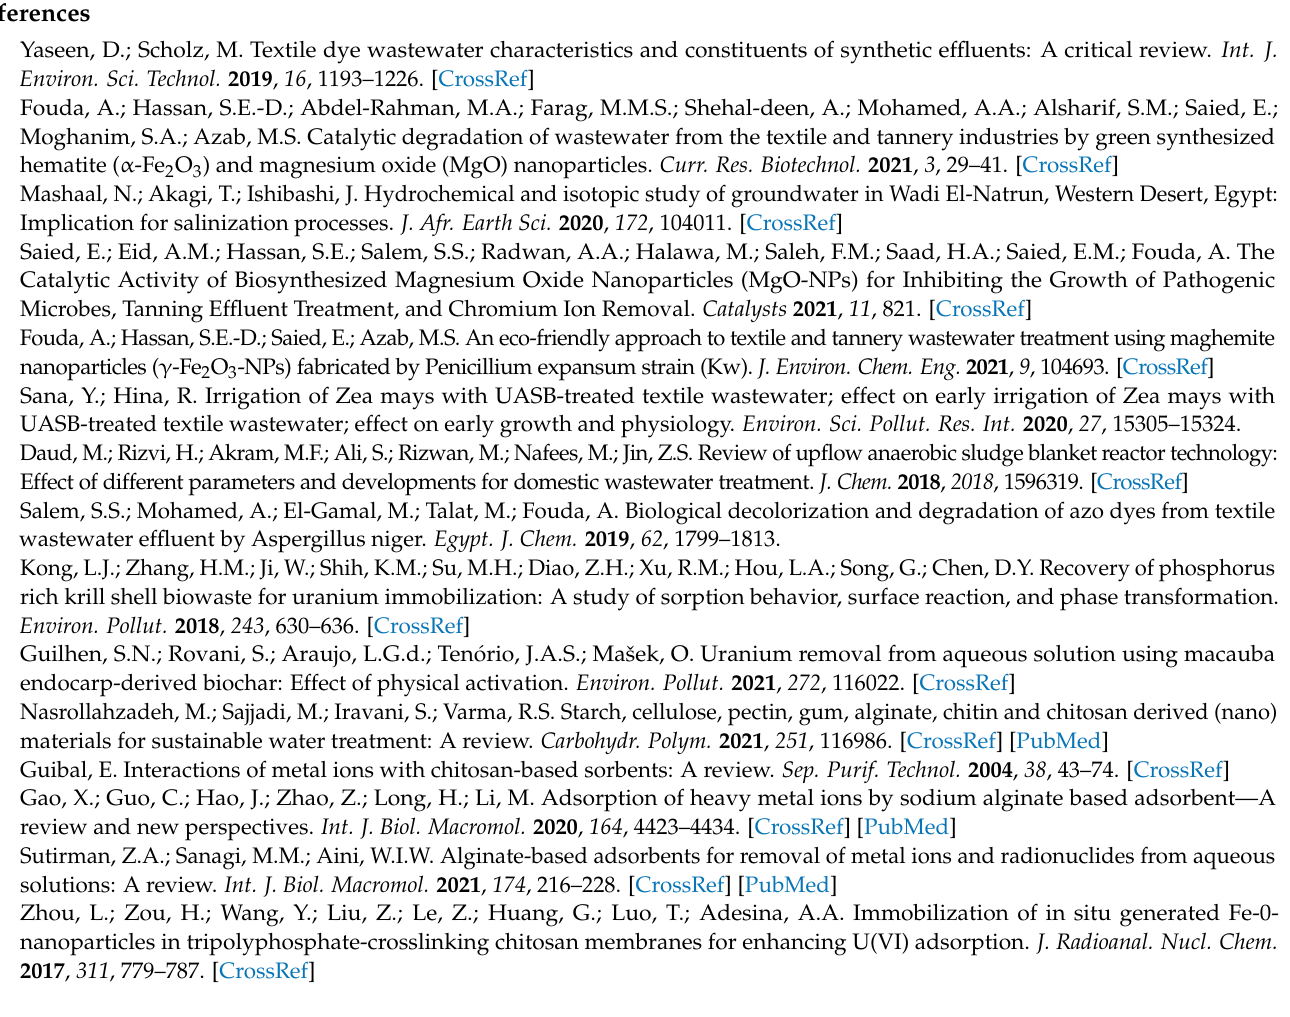
reference file. Table S2: Elemental analysis of MCc and MCa-ATA sorbents; Table S3: